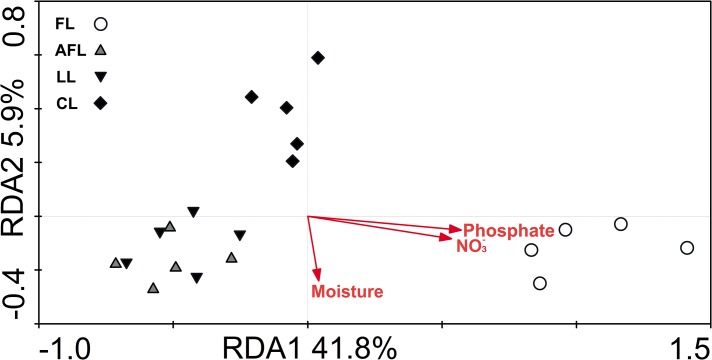
Redundancy analysis of the effect of soil parameters on ammonia-oxidizing bacterial communities using the terminal restriction fragment length polymorphism data.Only the soil parameters which significantly explained (p < 0.05 by 499 permutations) the ammonia-oxidizing bacterial community variation were shown. FL, farmland, AFL, abandoned farmland, LL, Lolium perenne L. land, CL, Caragana korshinskii Kom. land.